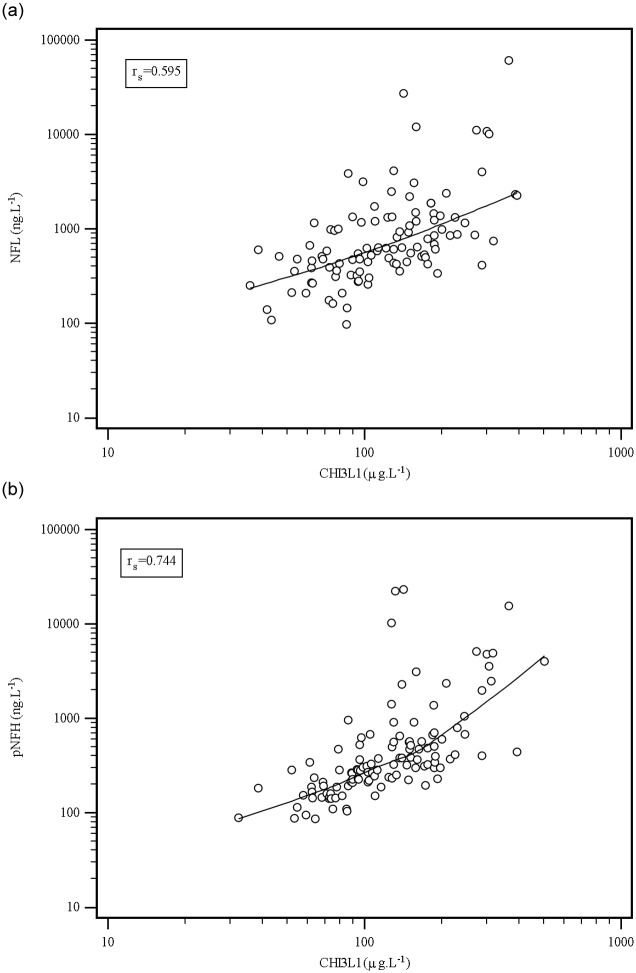
Passing-Bablok regression analysis of CHI3L1 and NFL, respectively pNFH concentrations in all groups.rs = Spearman correlation coefficient. The correlation between CHI3L1 and NFL and pNFH in cerebrospinal fluid, P < 0.0001.